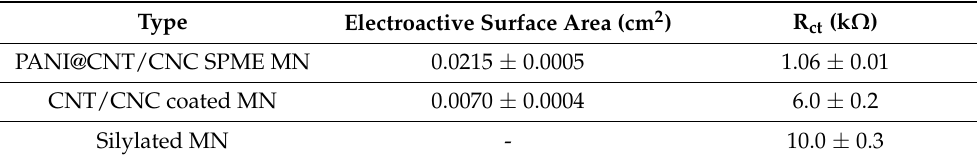
Figure 4. ( a ) Representative CV scans taken at 0.10 V/s and ( b ) Overlapped linear plot of peak cathodic current (i p ) vs. square root of scan rate for PANI@CNT/CNC SPME MN and CNT/CNC coated MN acquired in 5.0 mM K 3 FeCN 6 (in 0.1 M KCl). Table 1. Electroactive surface area and electron transfer resistance (R ct ) values for PANI@CNT/CNC SPME MN, CNT/CNC coated MN, and silylated